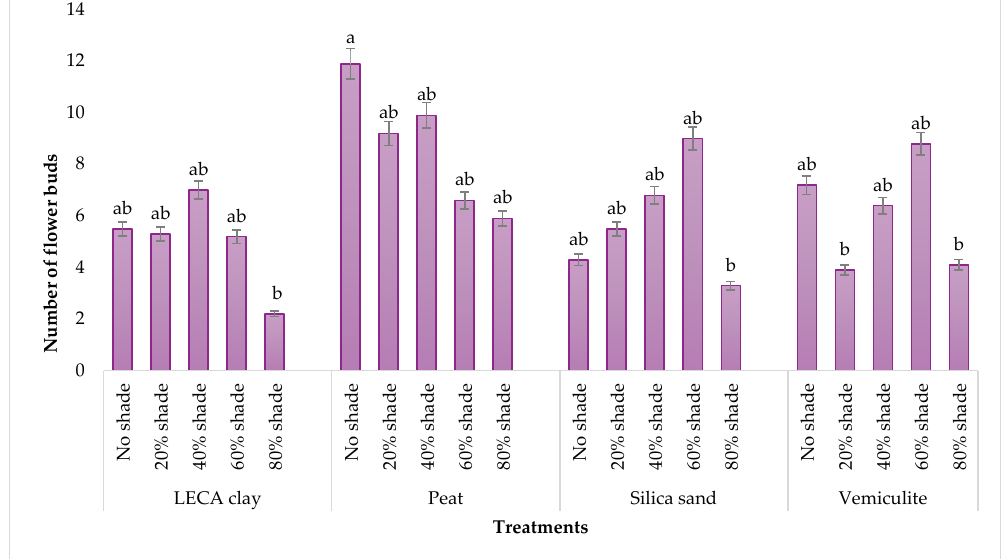
Figure 2. The effect of different growth media and shade levels on leaf length of T. divaricata . Means at the same column followed by the same letter do not differ by Tukey ’ s test ( p > 0.05).